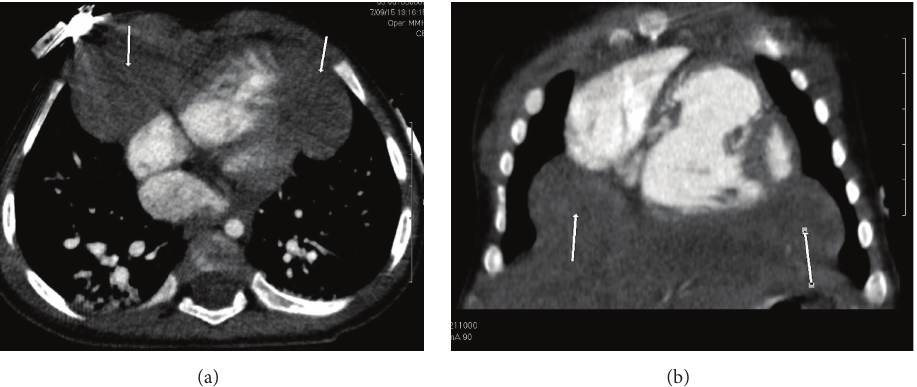
Figure 1: Axial (a) and coronal (b) images from a cardiac CTA of the chest show focal, bilateral anteromedial herniation of liver (arrows).